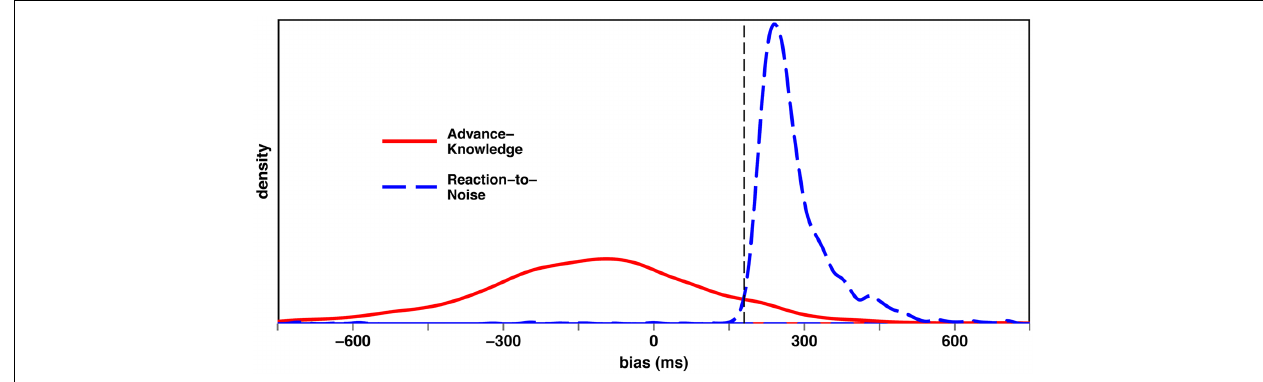
FIGURE 5 |Anticipation and reaction intervals.